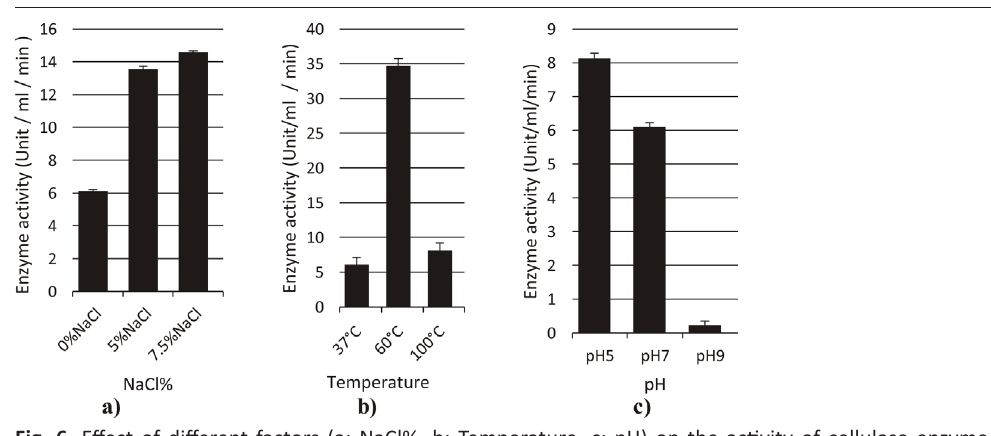
Fig. 6. Effect of different factors (a: NaCl%, b: Temperature, c: pH) on the activity of cellulase enzyme from Streptomyces ghanaensis